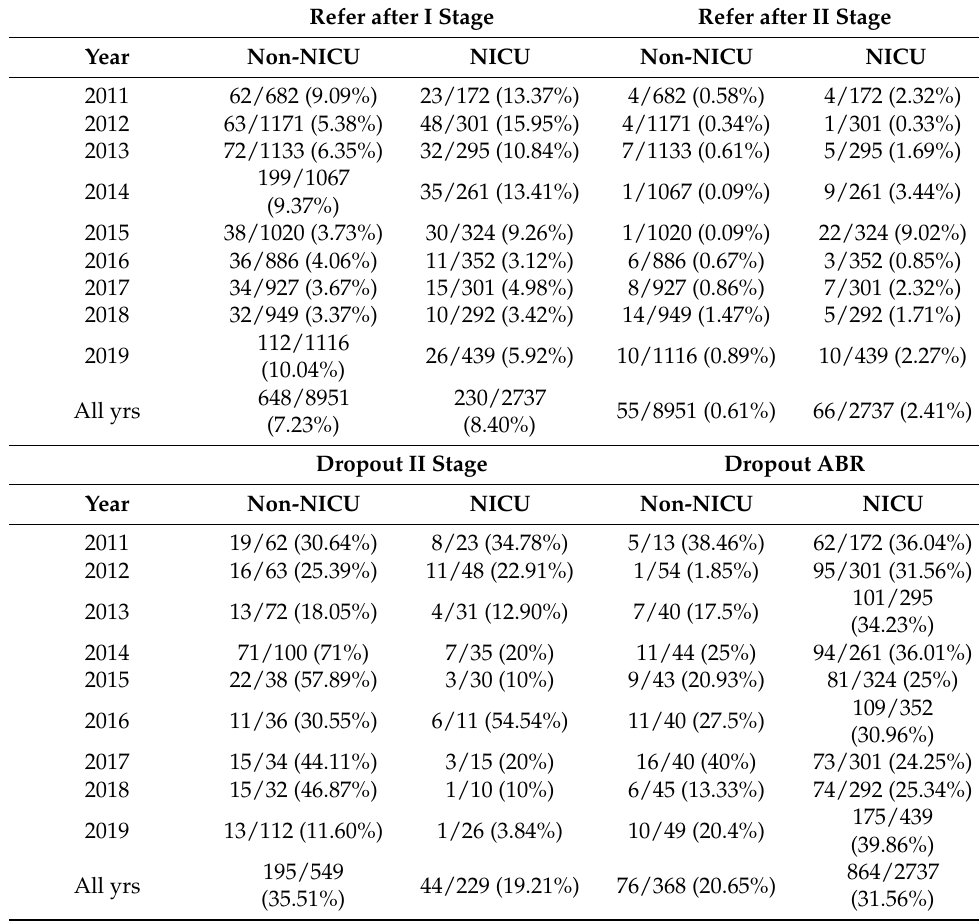
Table 1. Refer and dropout rates by year and overall values. Refer after I Stage Refer after II